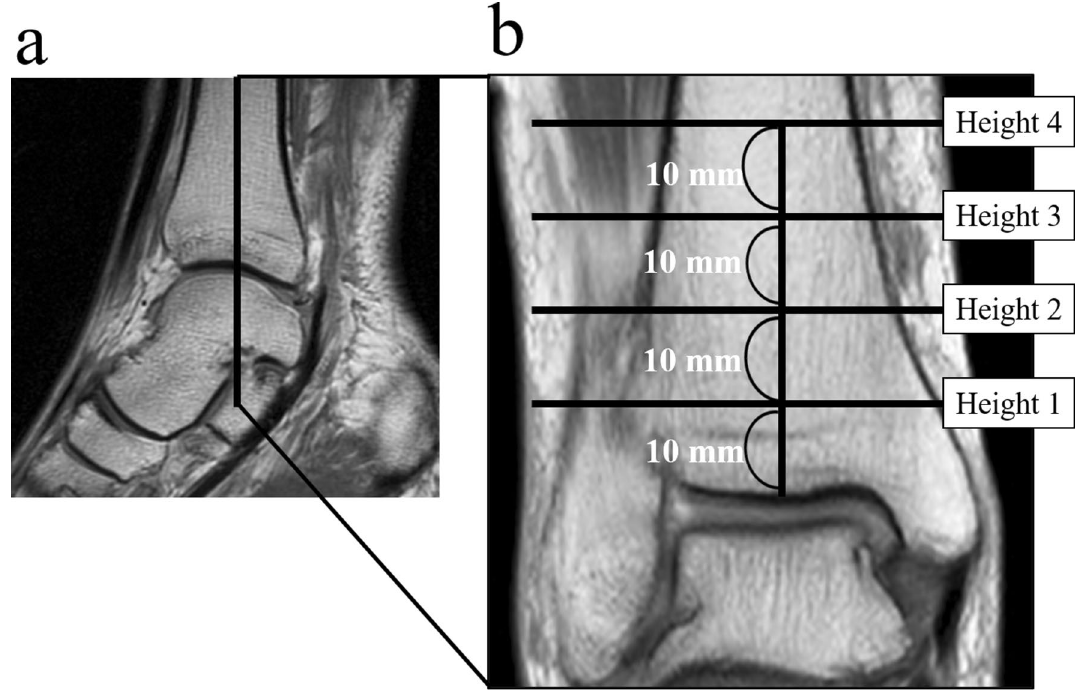
Figure 1. Axial images perpendicular to the coronal images used to determine the location of the great saphenous vein. ( a ) The coronal image is set using sagittal images. ( b ) The tibial axis is set using coronal images, and heights 1–4 were located 10, 20, 30, or 40 mm proximal to the tibial